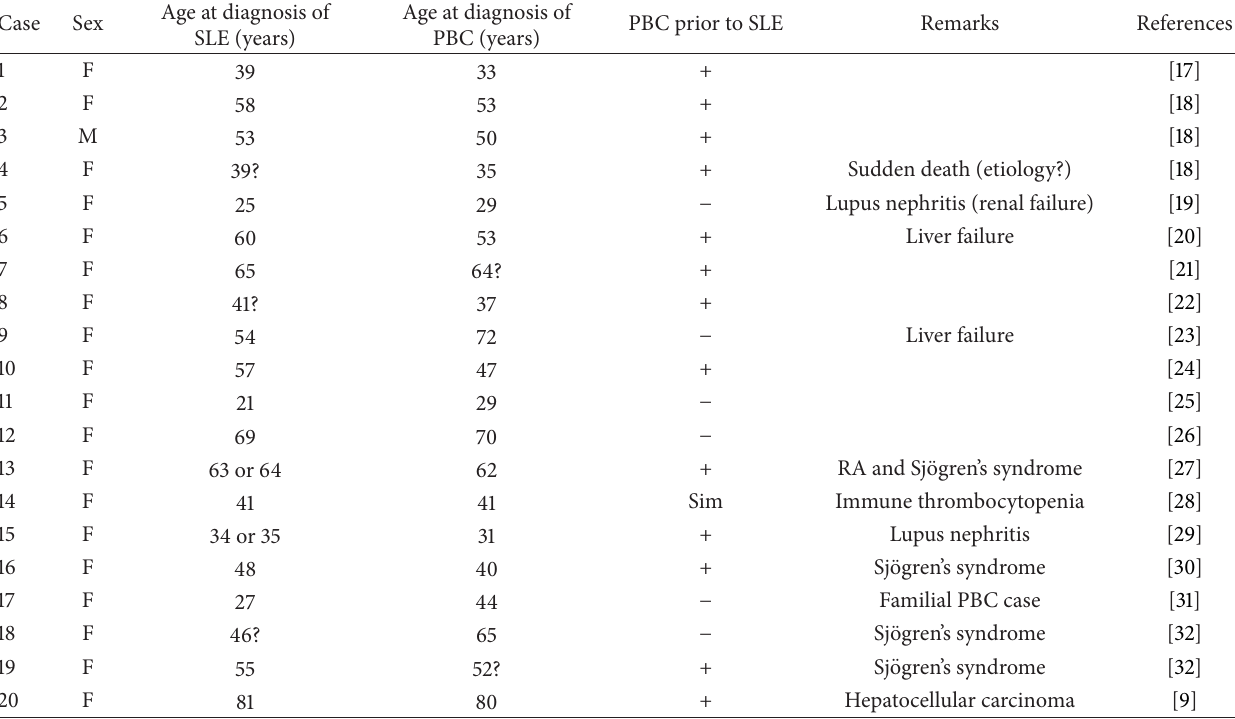
Table 1: Characteristics of 20 systemic lupus erythematosus patients with concomitant primary biliary cirrhosis derived from the literature in English and Japanese.